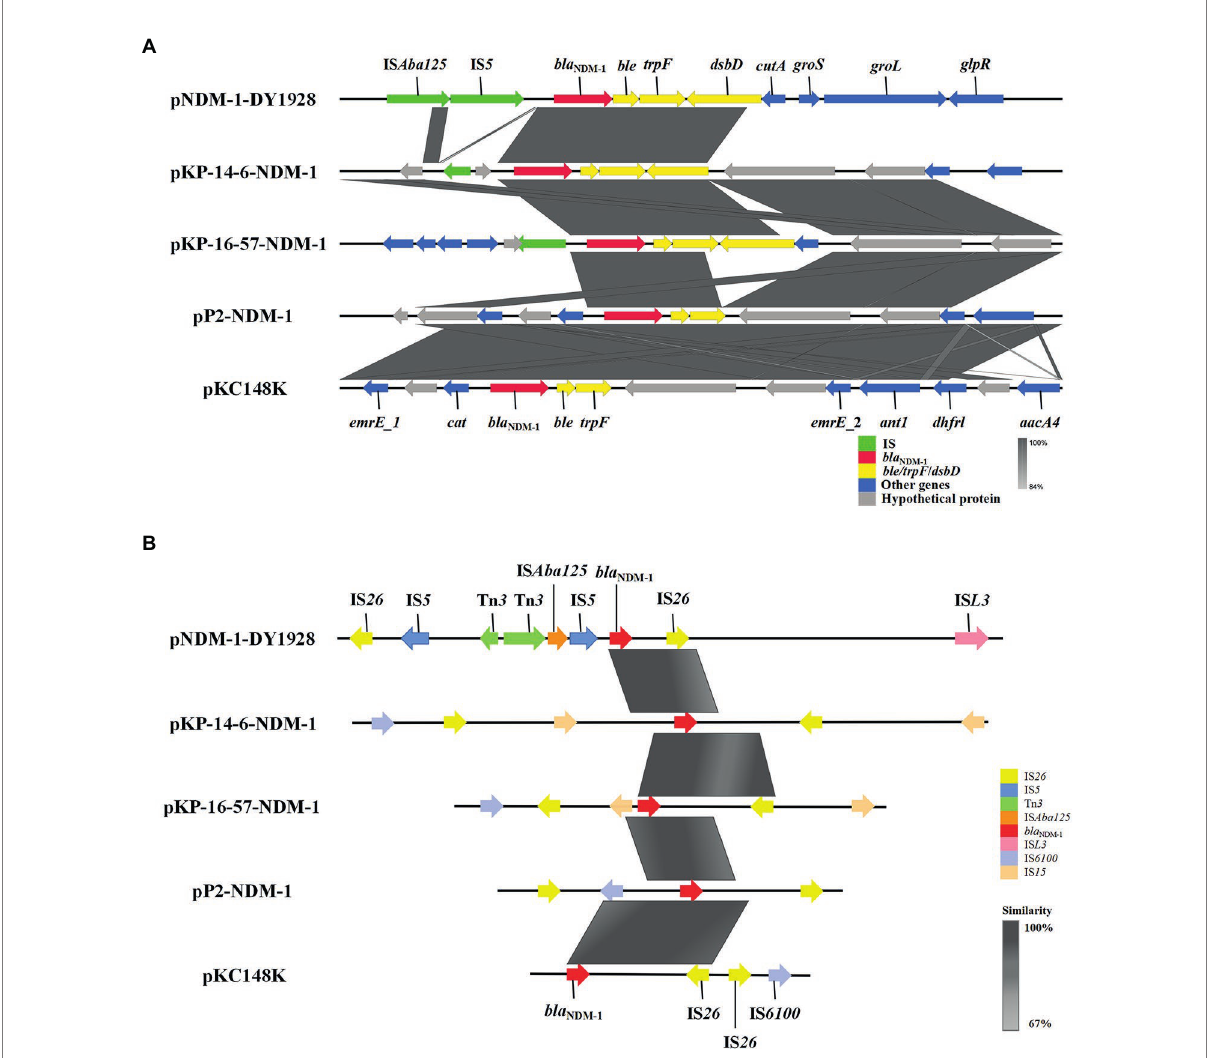
FIGURE 2 Genetic environment of bla NDM-1 on pNDM-1-DY1928 and relevant plasmids: pKP-14-6-NDM-1, pKP-16-57-NDM-1, pP2-NDM-1 and pKC148K. (A) Open reading frames (ORFs) are shown as arrows, and are exhibited according to their putative functions. Regions that share a high degree of sequence similarity are indicated by gray. IS elements are colored green, ARGs are red, and conjugal transfer associated genes are yellow. Other genes are colored blue, and assumptive genes that encoded proteins are gray. (B) IS elements around the bla NDM-1 gene are shown as arrows with corresponding colors indicated in the legend. Regions that share a high degree of sequence similarity are colored as